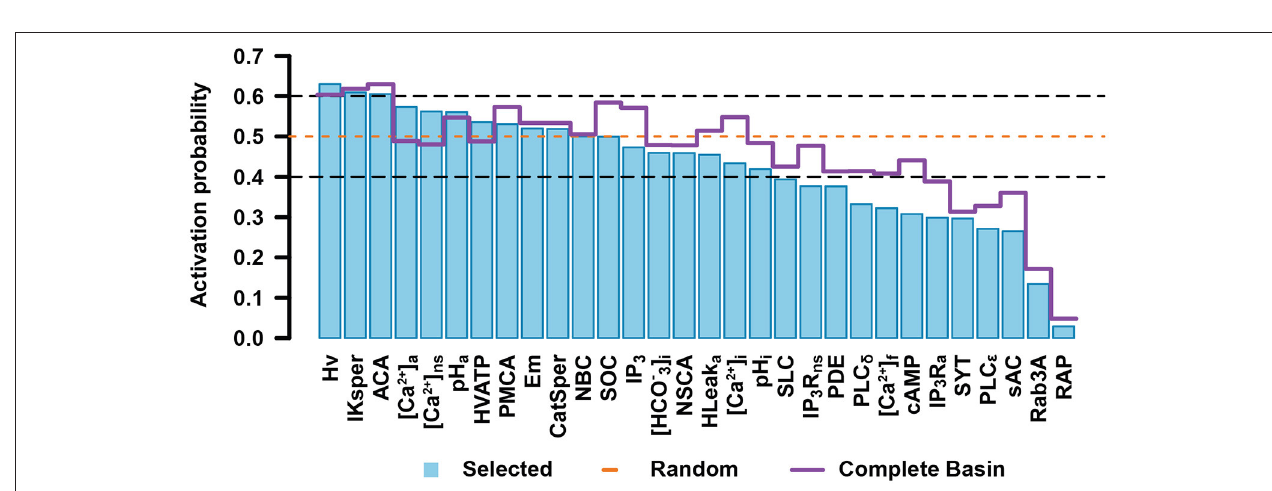
FIGURE 6 | Activation probability of network nodes in the set of initial states. Bar heights for each node represent the probability that the node is in the active state. The orange dashed line points out the activation probability of a completely random set of initial states. The purple straight line represents the activation probability of each node on the entire set of states conforming the basins of attraction for all the attractors. Nodes whose activation probability is between 0.4 and 0.6 are enclosed in black dashed lines. Error bars are not shown since in each case standard deviation is below 0.001.